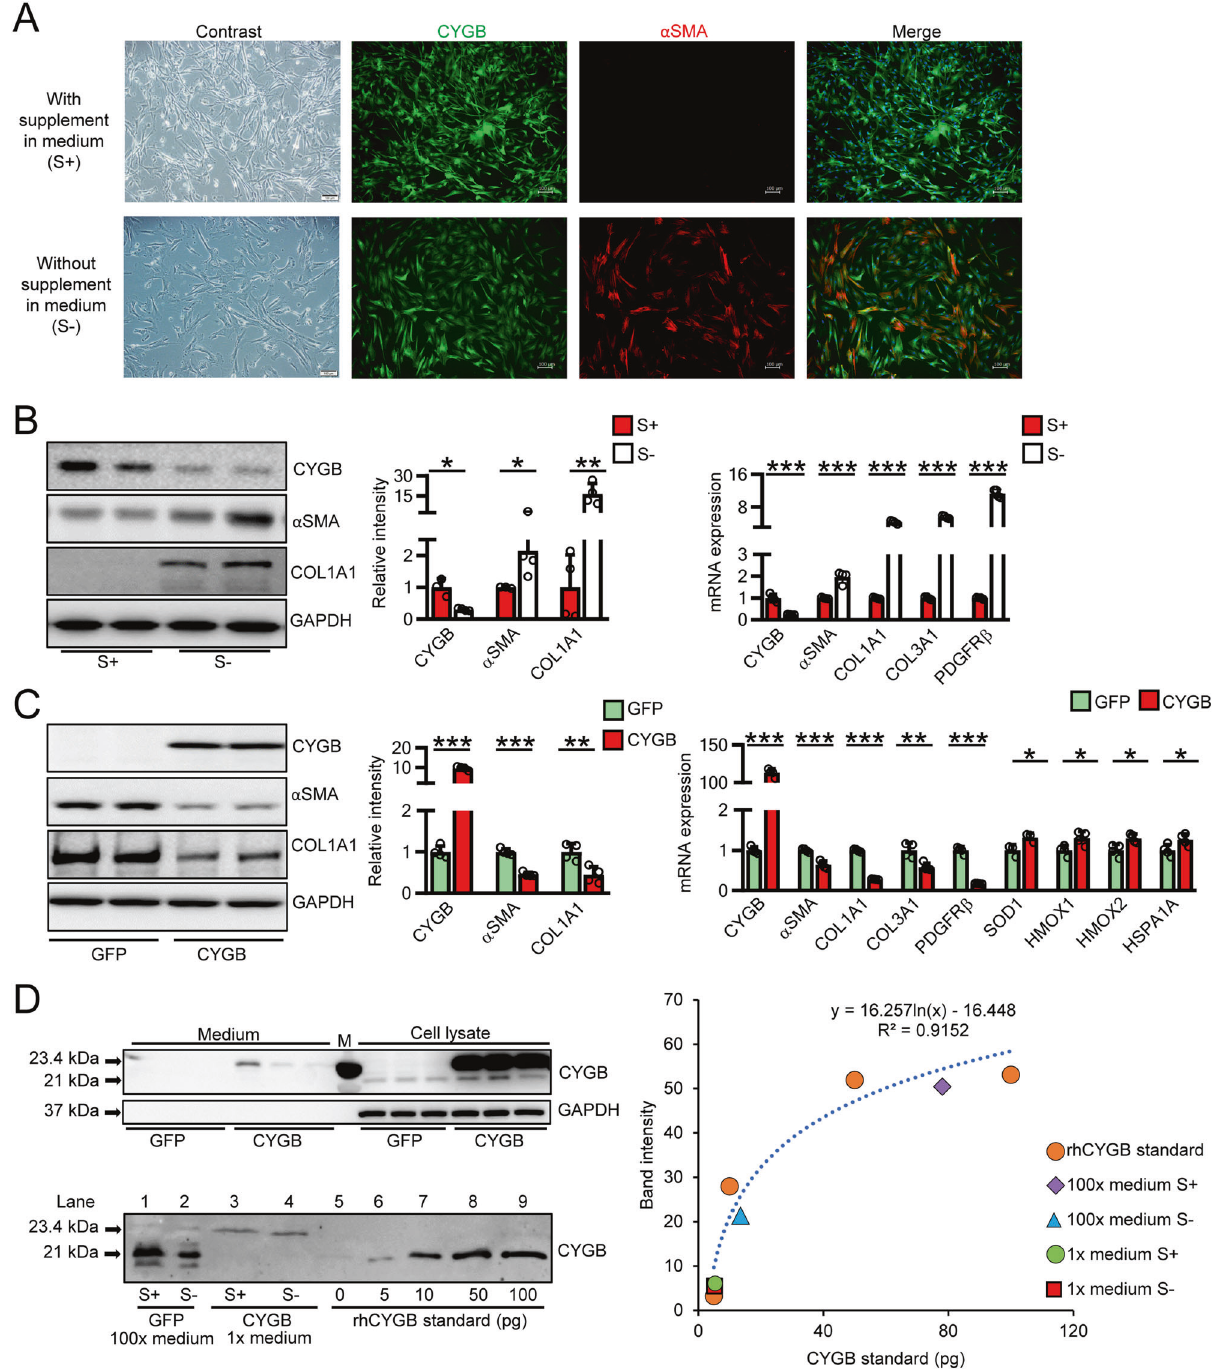
proliferation was dose-dependently suppressed by rhCYGB, with an IC 50 value of 2.5 µM (Fig. 5B). To understand the underlying mechanism, we performed RNA- seq analysis of untreated and rhCYGB (4 μ M)-treated MIA PaCa-2 cells ( n = 3 per group) and found that the expression of 3721 genes was changed by 2-fold or higher in the rhCYGB-treated group (Supplemental Fig. 5A). Gene set enrichment analysis showed that gene ontology terms associated with biological processes, such as “ nuclear division ” , “ positive regulation of cell cycle ” , and “ DNA replication ” , were overrepresented among differentially expressed genes (Supplemental Fig. 5B). (Fig. 5D). At the protein level, rhCYGB treatment boosted